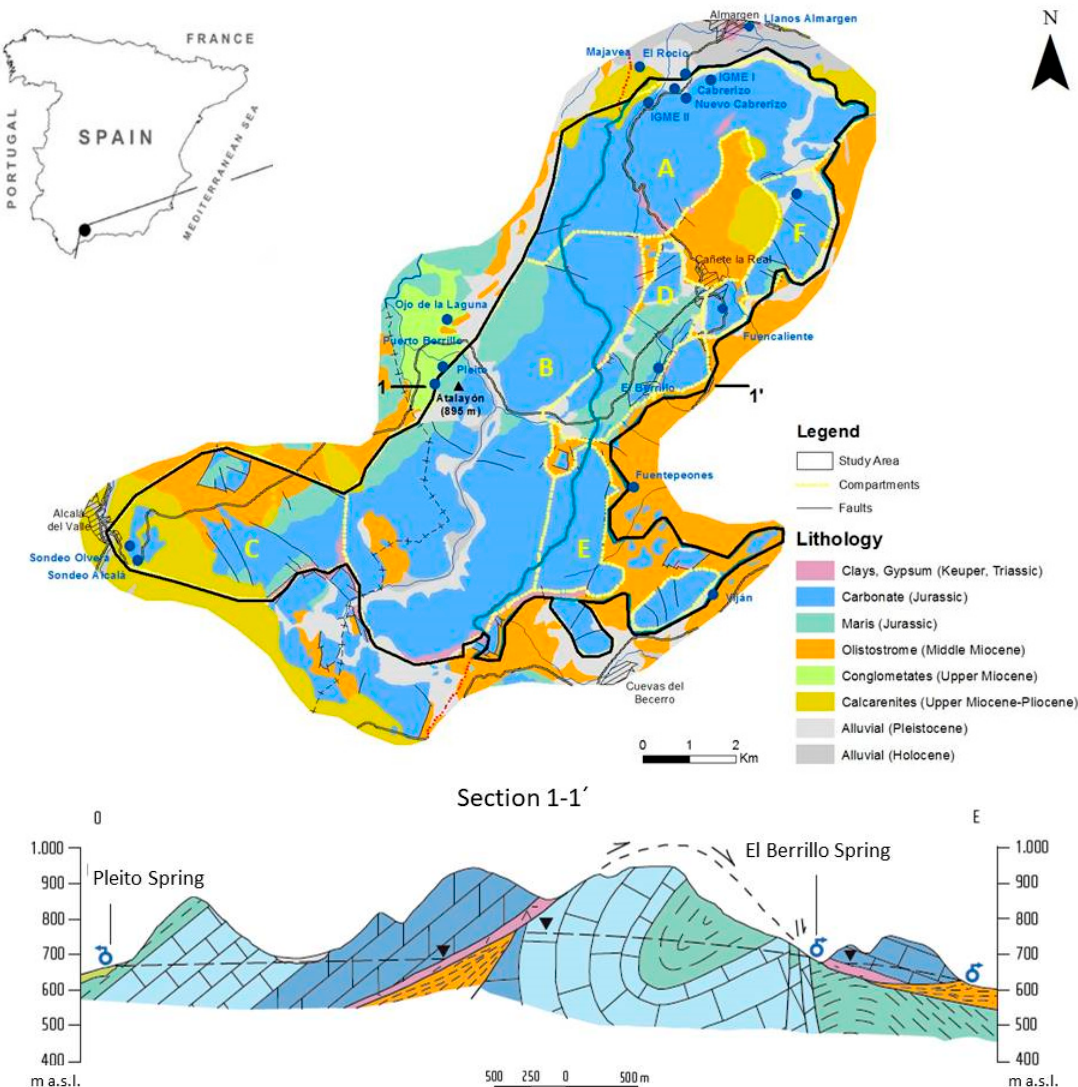
Figure 3. Hydrogeological setting of Sierra de Cañete.